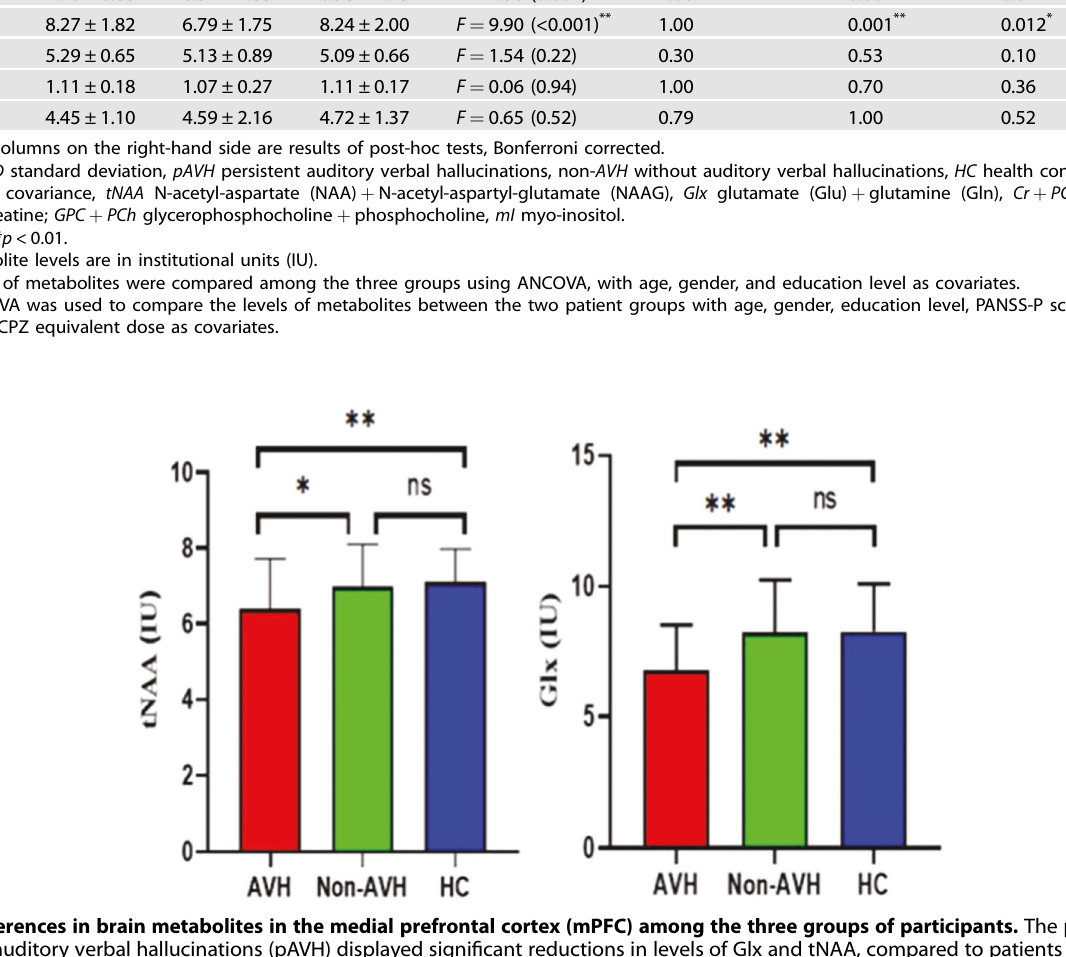
Table 3. Metabolite concentrations and CRLB in the mPFC in SCZ patients and healthy controls a . Variable